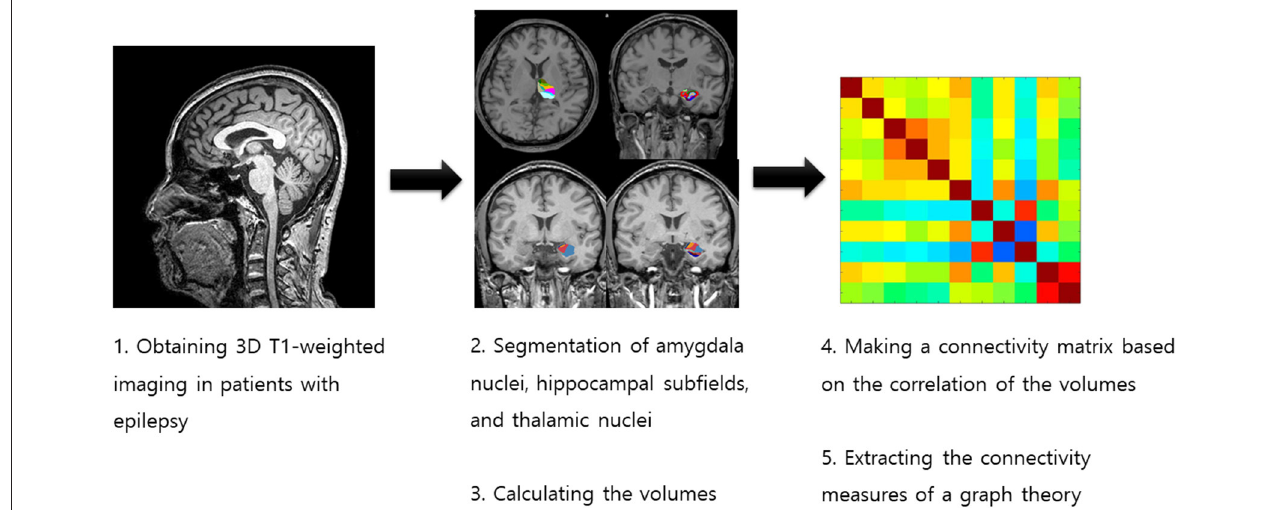
FIGURE 1 | Process for obtaining the intrinsic amygdala, hippocampal, and thalamic networks in temporal lobe epilepsy patients with hippocampal sclerosis.